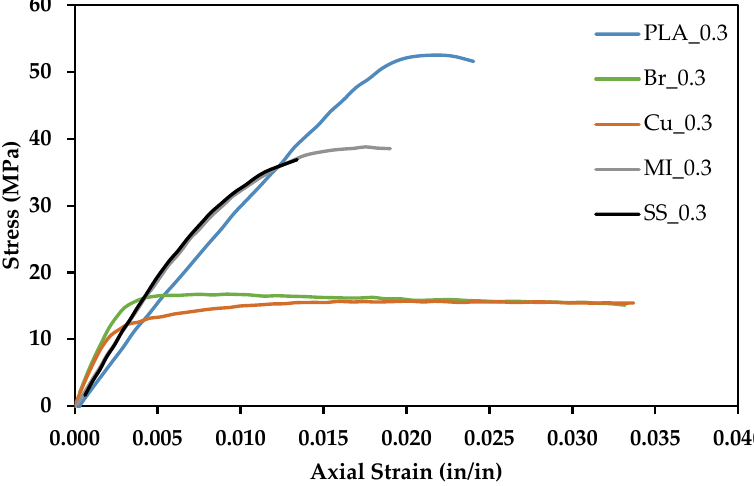
Figure 11. Average tensile response for PLA and metal reinforced PLA at 0.3 mm print layer height.